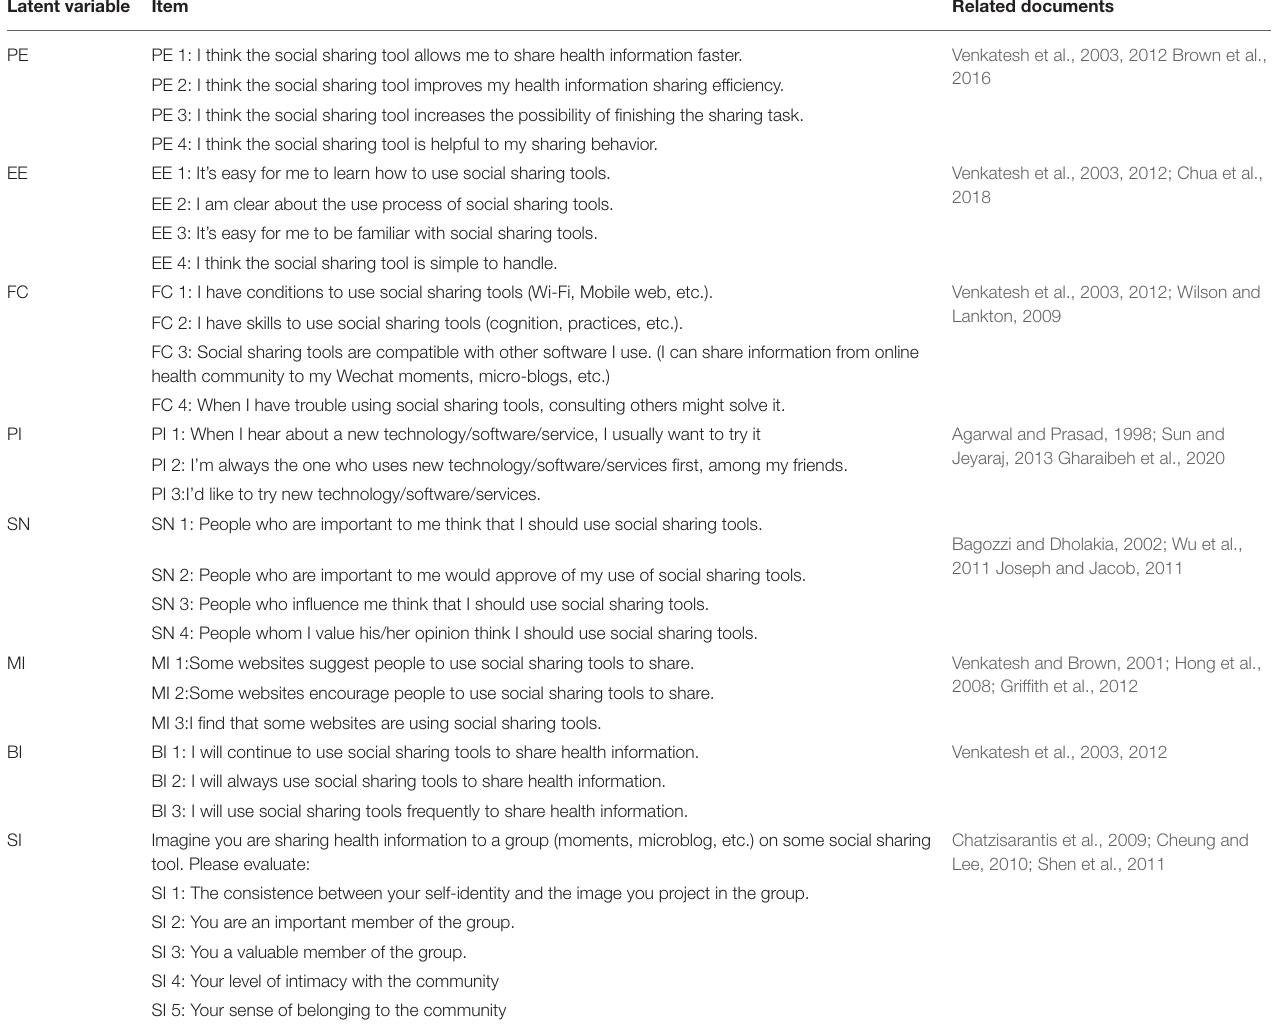
TABLE 2 | Questionnaire survey